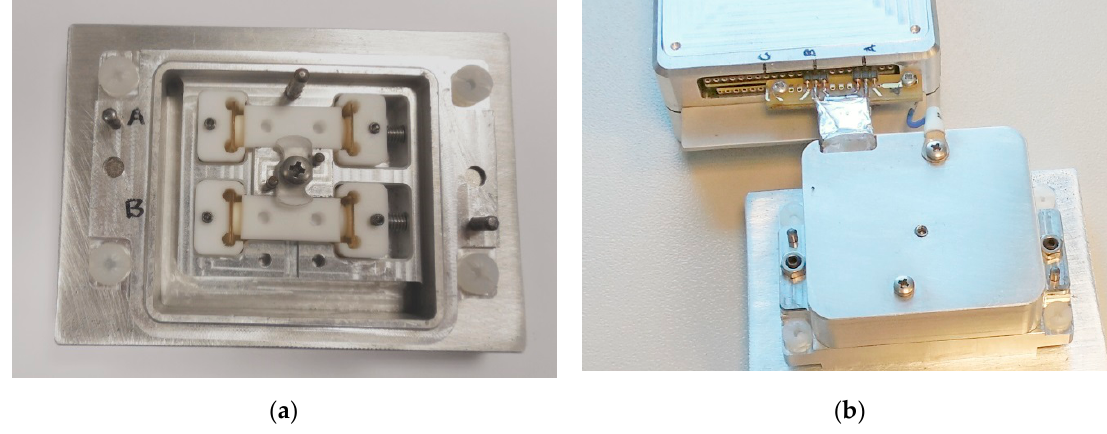
Figure 16. Two sensors in the aluminum base part ( a ) and sensors unit connected to the EIS analyzer ( b ).